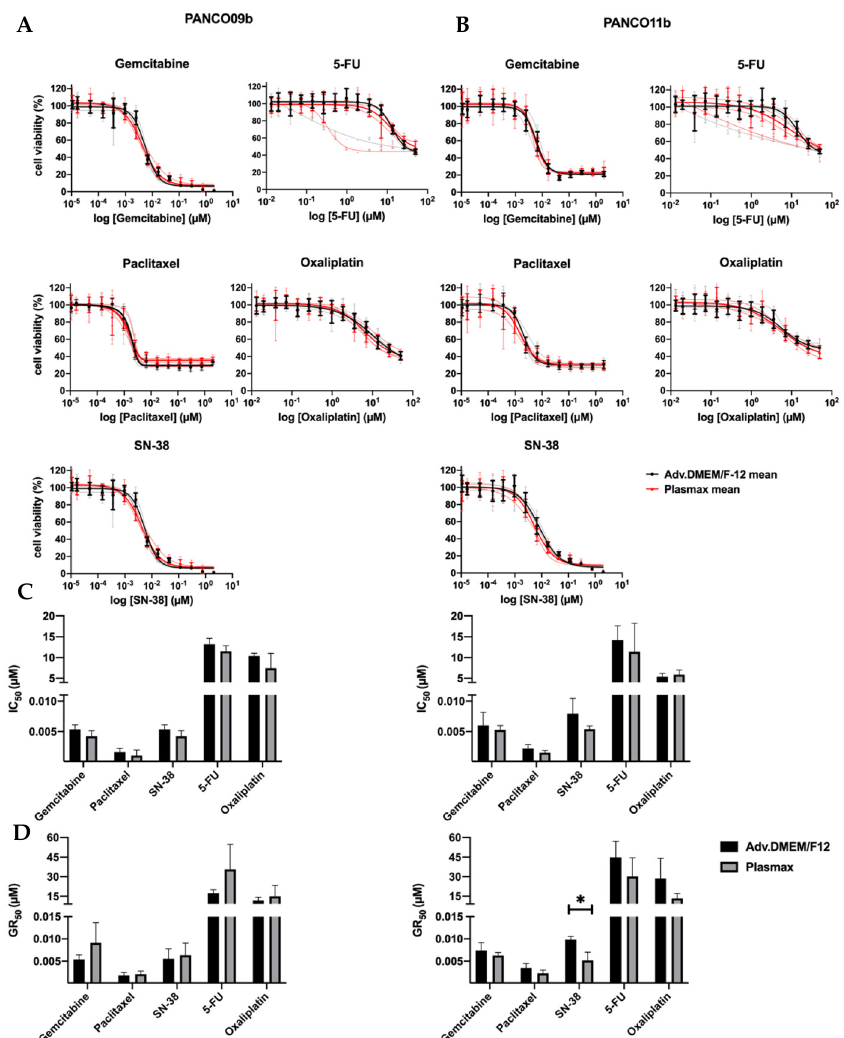
Figure 4. Sensitivity of 2D cultured PANCO09b and PANCO11b cells to gemcitabine, paclitaxel, SN-38, 5-FU, and oxaliplatin in adv.DMEM/F-12 versus Plasmax. ( A ): Dose–response curves of PANCO09b cells grown in adv.DMEM/F-12 or Plasmax. ( B ): Dose–response curves of PANCO11b cells grown in adv.DMEM/F-12 or Plasmax. Thick, dark lines represent the mean and light, thin lines show independent experiments in triplicates. ( C ): Bar graph of IC 50 values of PANCO09b and PANCO11b cells grown in adv.DMEM/F-12 or Plasmax. ( D ): Bar graph of GR 50 values of PANCO09b and PANCO11b cells grown in adv.DMEM/F-12 or Plasmax. Data are presented as mean ± SD of three independent experiments performed in triplicate. Independent sample t -test was performed to assess differences. * = p < 0.05.